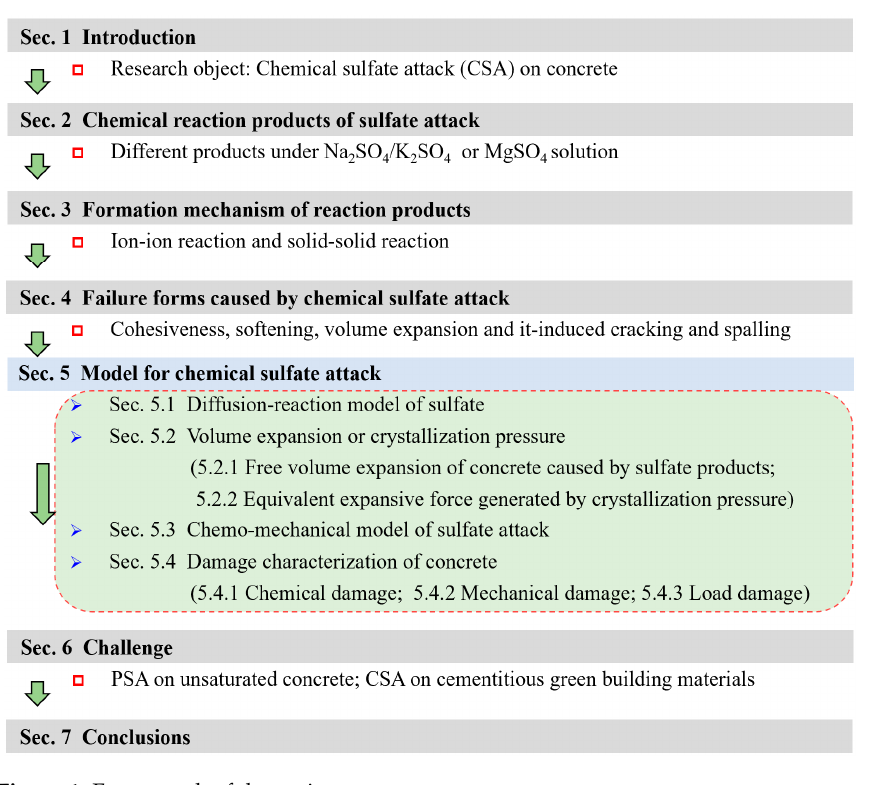
Figure 1. Framework of the review.